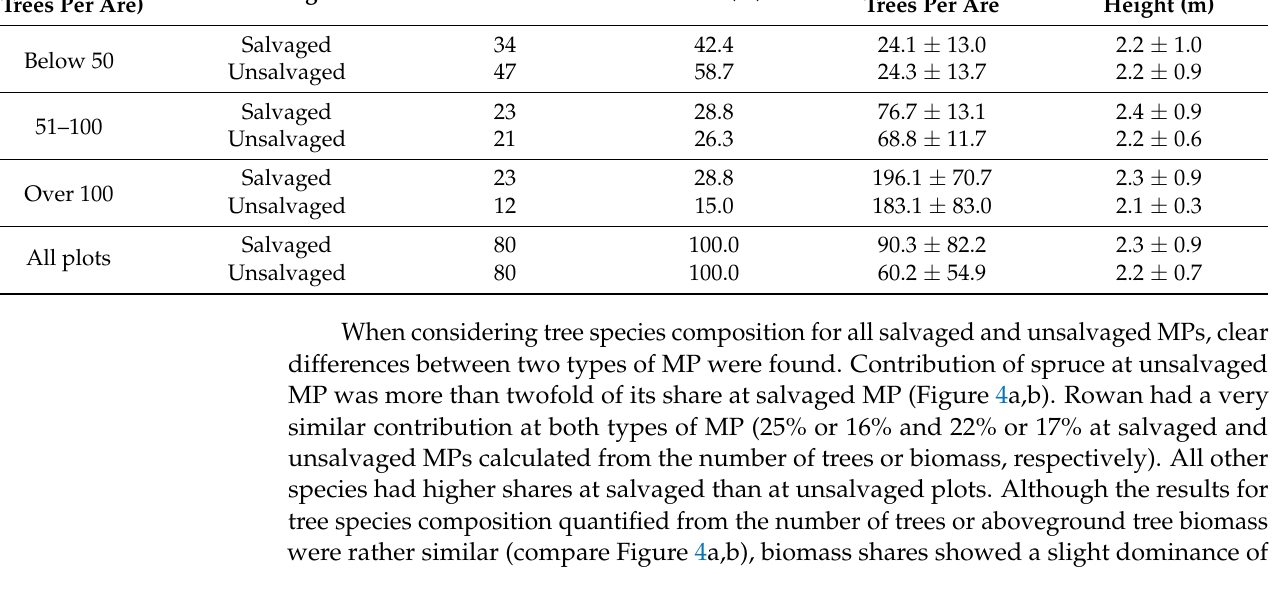
Figure 3. Comparison of mean number of trees ( a ), mean number of tree species ( b ), Lorey’s tree height ( c ) and total aboveground biomass ( d ) at monitoring plots (MPs) located in salvaged and unsalvaged parts of the area (the High Tatra Mts. in 2019). Differences were tested with an LSD test, which confirmed significant differences in mean number of trees, mean number of tree species and total aboveground biomass (in all cases p < 0.001), but not for tree height ( p = 0.552). Error bars show standard errors. Table 3. Share of salvaged and unsalvaged monitoring plots grouped with regard to tree density and their average number ( ± standard error; the High Tatra Mts. in 2019). Density Group Monitoring Plots Number of (Trees Per Are)